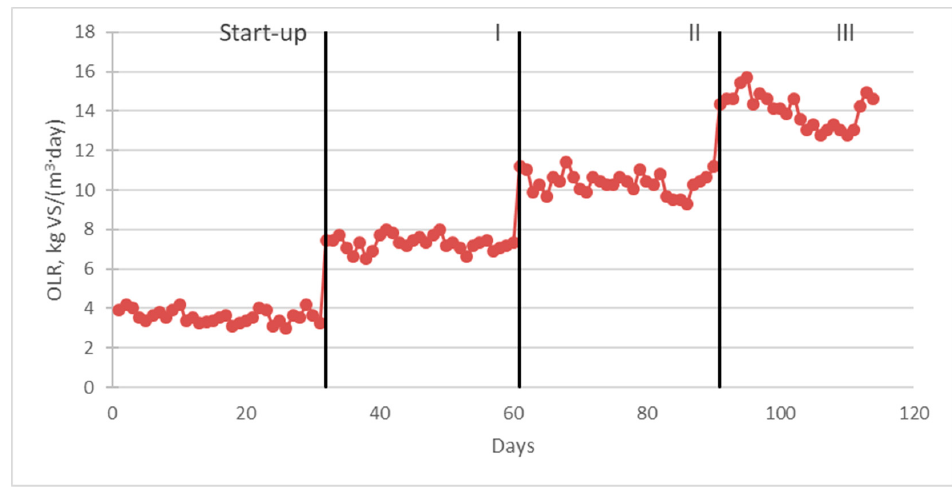
Figure 4. Change in organic loading rate (OLR) throughout the experiment.